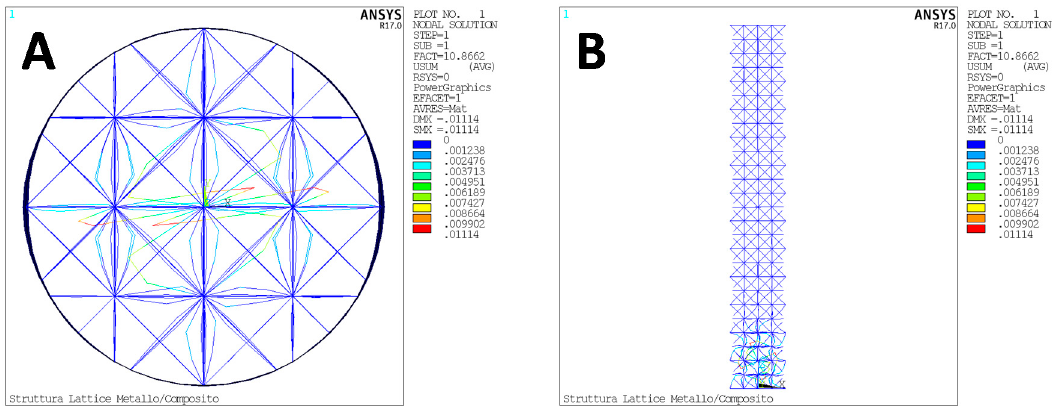
Figure 21. Test case 2—1 st buckling mode. Total Displacement: entire model (A) and detail (B).